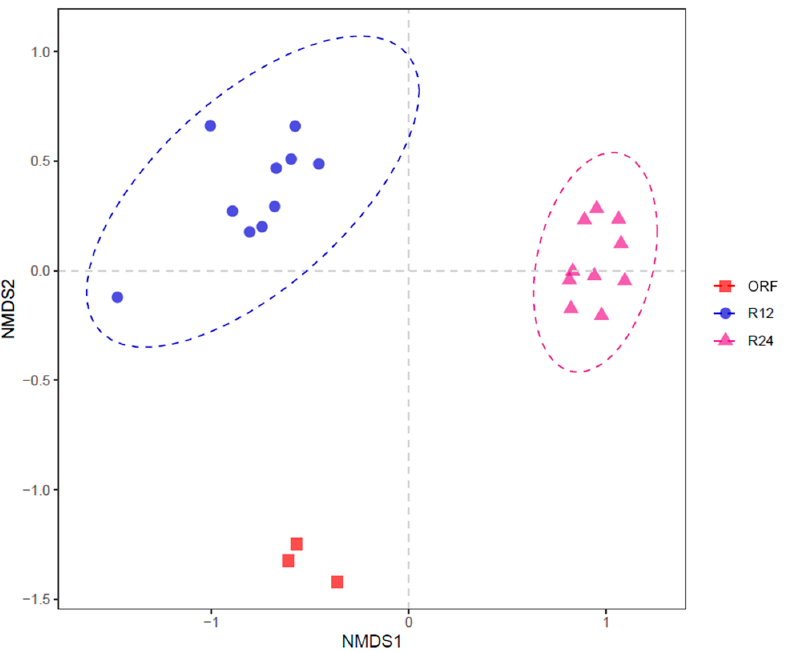
Figure 3. Non-metric multidimensional scaling (NMDS) of rumen bacterial communities based on Bray–Curtis distances. ORF, original rumen fluid; R12, in vitro rumen fermentation at 12 h; R24, in vitro rumen fermentation at 24 h.